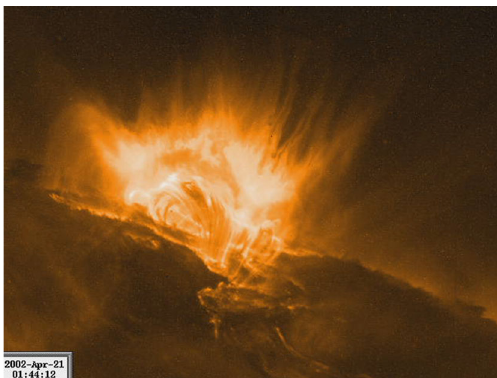
Fig. 3 Still from a movie: The flare SOL2002-04-21 observed in the Fe xii line at 195 Å (sensitive to 1.5 MK plasma) by the TRACE satellite. Note the different phases, starting with irregular brightening in the impulsive phase. The luminosity peaks when a sheet-like structures appears above the initial brightening. The diffuse emission at this time is attributed to the presence of the Fe xxiv (192 Å) line within the TRACE passband, emitted by a plasma of 20 MK. The flare proceeds into a long decay phase with post-flare loops growing in height (credit: TRACE Project,